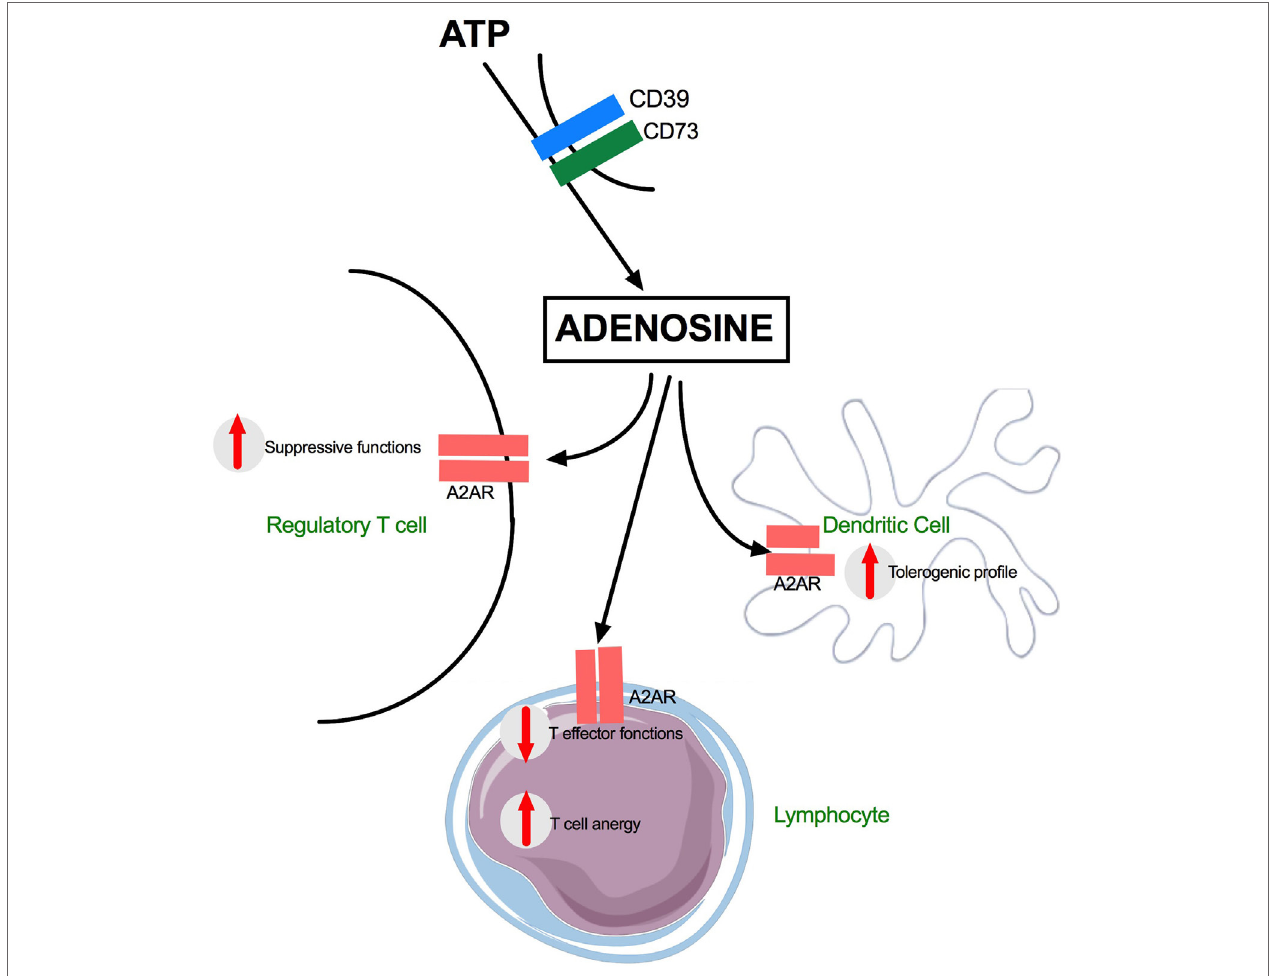
FiGURe 2 | Adenosine effects on dendritic and T cells during trauma. G protein-coupled surface receptors (GPCR) are key actors of Adenosine mediated inflammatory after trauma. A2AR receptors are expressed on many subsets including Regulatory T cells, effector T cells, and dendritic cells. ATP, adenosine 5’-triphosphate; CD39, nucleoside triphosphate diphosphohydrolase-1; CD73, surface-expressed ecto-5 ′ -nucleotidase; A2AR, adenosine A2A